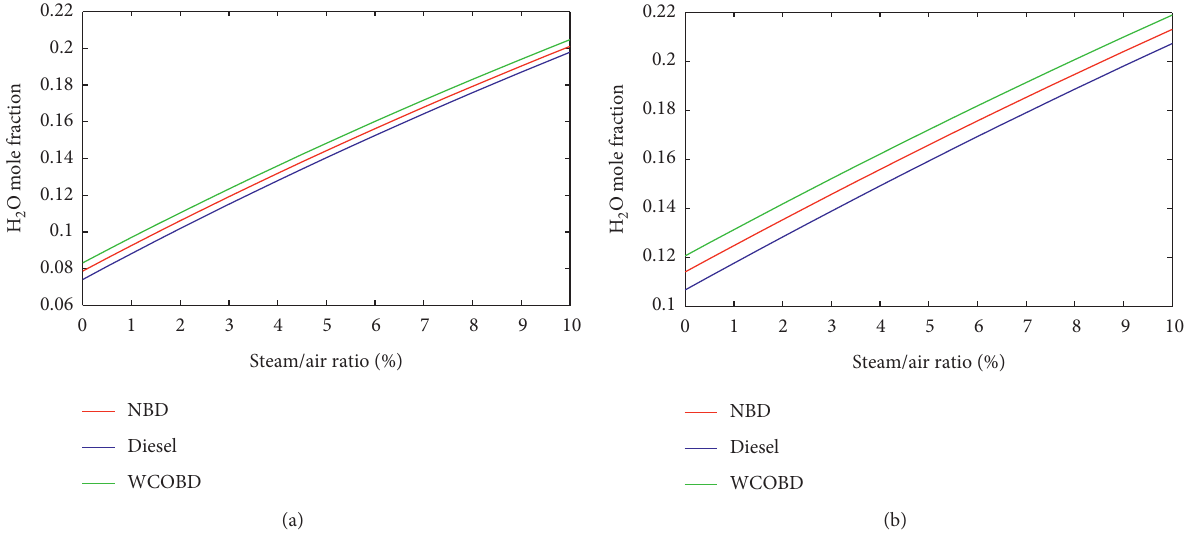
Figure 2: Variation of H 2 O equilibrium mole fractions with steam injection